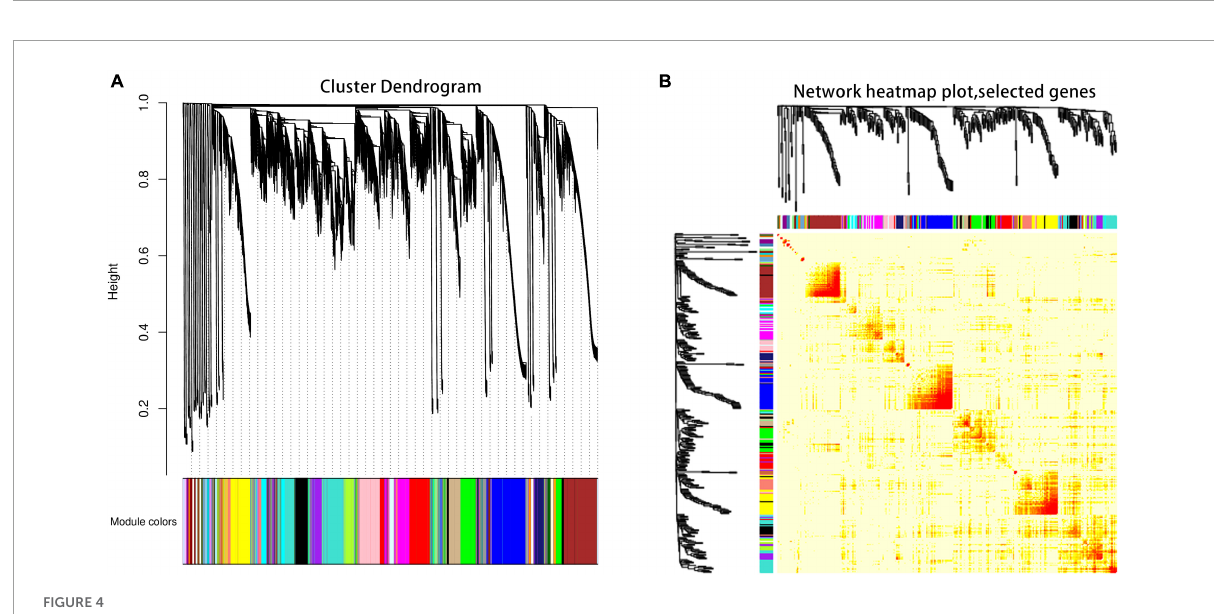
FIGURE4 Gene module construction (A) and correlation analysis (B)